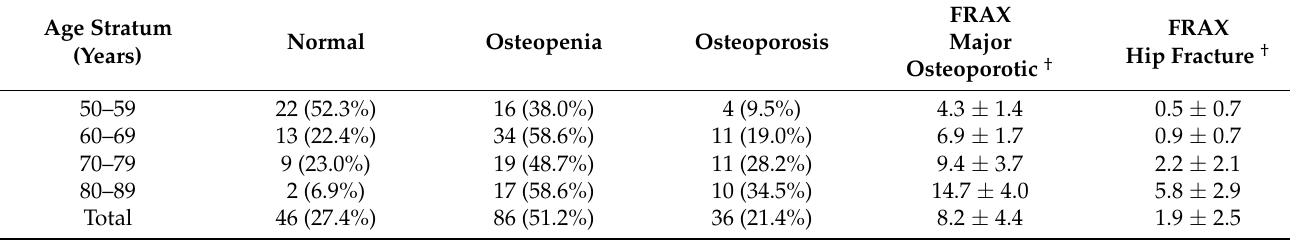
Table 2. Prevalence of osteoporosis and osteopenia and 10 year probability of fractures calculated by FRAX.